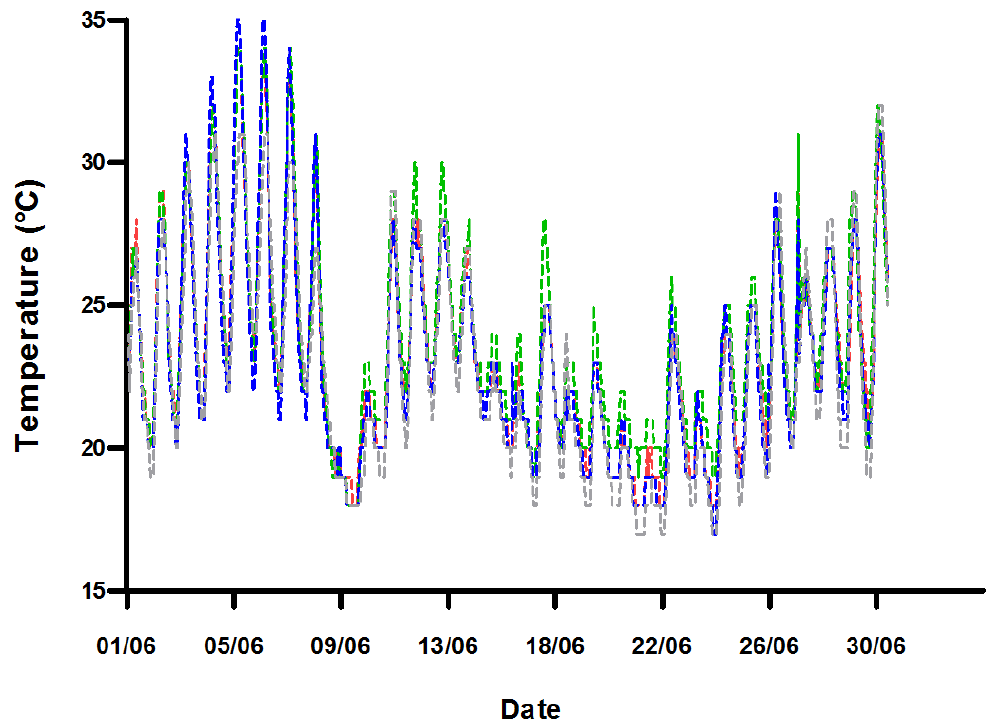
Figure 1. Plant root zone temperature (°C) in aquaponic systems A (red), B (green), and C (blue), and in hydroponic system D (grey).